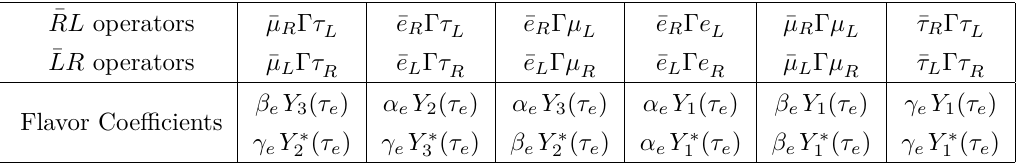
Table 1 . Flavor coefficients of the bilinear operators of charged leptons in the flavor